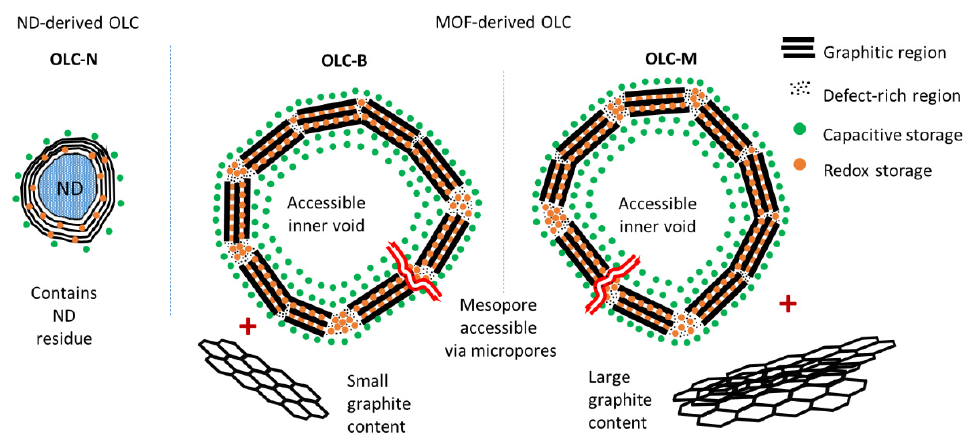
Figure 5. Schematic representation of the OLCs produced from nanodiamond and